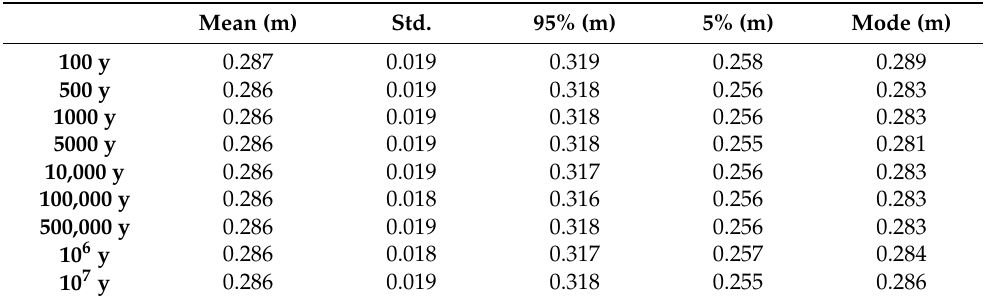
Table 14. Probabilistic flood hazard analysis results for the control building of NPP 4 (elevation 80 ft).